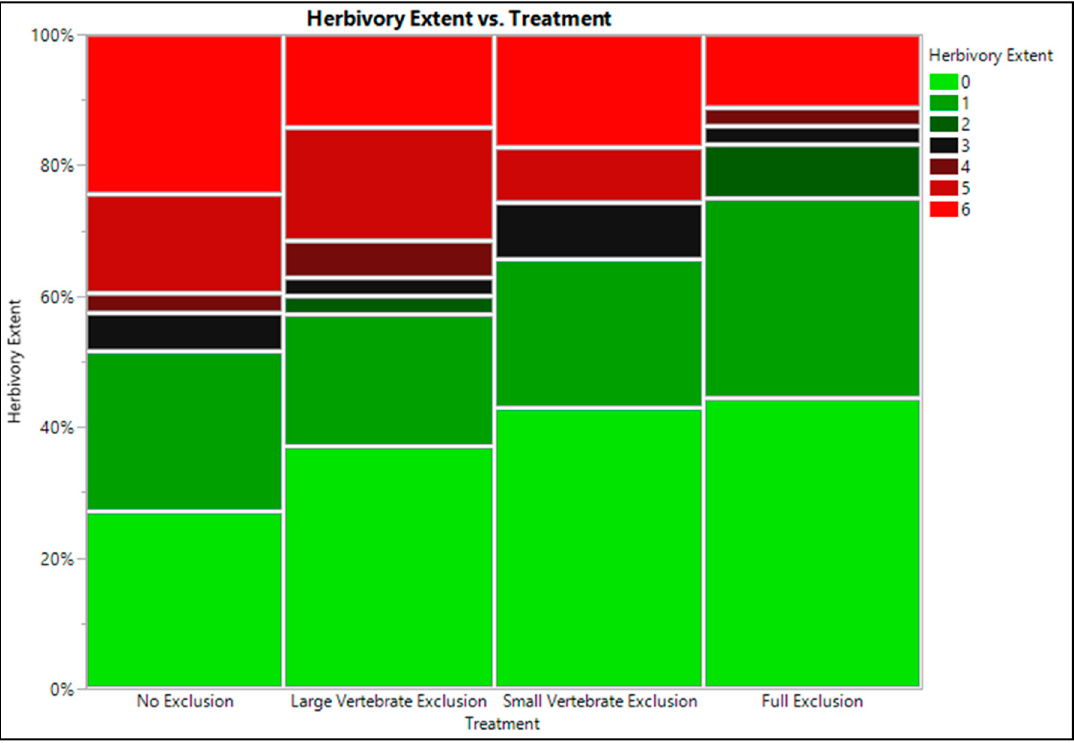
Figure 2. Distribution of herbivory extent classification for each event occurring on poison ivy ( Toxicodendron radicans ) plants in each of our four herbivore-exclusion treatments—no exclusion; large vertebrate exclusion only; small mammal exclusion that also included large mammal exclusion; and full exclusion (no herbivory). Herbivory severity was classified according to the scale—(0) no herbivory, (1) low, classified as 1–25% of a leaf removed; (2) moderate, as 25–50% of a leaf removed; (3) high, as 50–99% of a leaf removed, (4) very high, as 1 full leaf removed, (5) severe, as 2 or more full leaves removed, or (6) death of the plant.